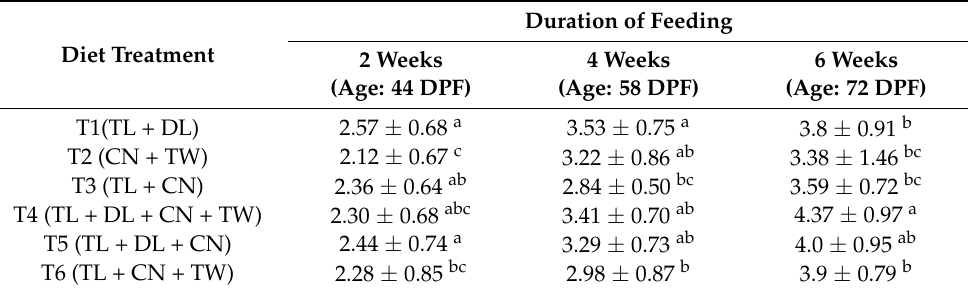
Table 3. Size (mm, mean length ± SD) of post-set sunray venus clams ( Macrocallista nimbosa) fed live microalgae diets. Different letters in the same column indicate significant differences among the treatments (one-way ANOVA, α = 0.05, a > b > c > d). DPF: days post fertilization.